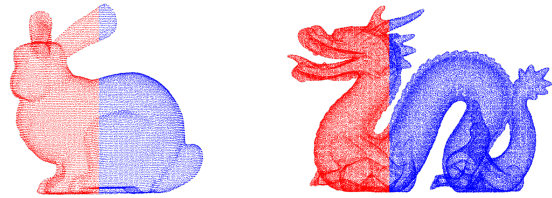
Figure 3. Bunny and Dragon models from the B3R dataset. Red color denotes the front part and blue color the back one as used for separate fine-tuning of the